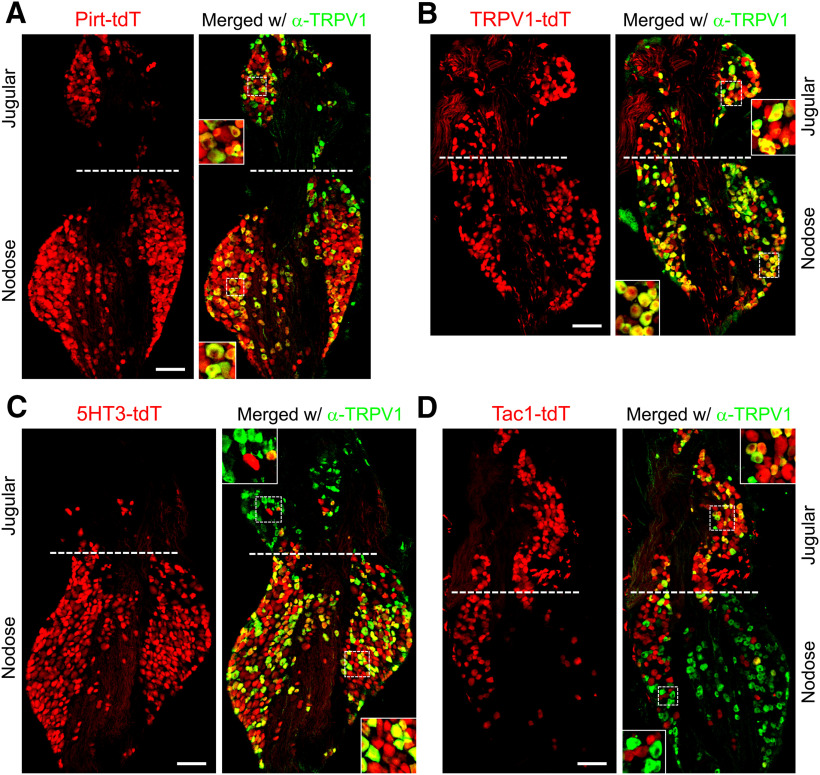
tdTomato expression and α-TRPV1 immunoreactivity in vagal ganglia. A, Pirt-tdT. B, TRPV1-tdT. C, 5-HT3-tdT. D, Tac1-tdT. Native tdTomato expression (red) is shown on the left, with overlap with α-TRPV1 immunoreactivity on the right (green). Scale bar, 100 μm; insets show enlarged views of both jugular and nodose neurons. Data are representative of n = 3 animals for each strain.